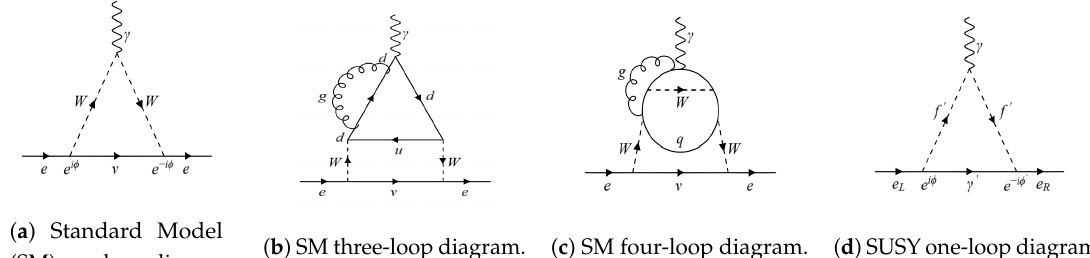
Figure 1. ( a ) One-loop Standard Model (SM) contribution to the electric dipole moment of the electron (eEDM). The phases in the two vertices cancel out, leaving behind no charge–parity (CP) violating contributions, resulting in zero eEDM at the one-loop level. ( b ) It turns out that there are no contributions at the two- and three-loop levels either; a sample three-loop diagram has been given above, and although an individual three-loop diagram itself may not vanish, the non-zero diagrams eventually cancel out [16], ( c ) The first non-zero contribution to the SM eEDM occurs at the four-loop level [17], and ( d ) supersymmetry (SUSY) contribution to the eEDM. The phases at the two vertices are different, and therefore, one can obtain a non-zero contribution to the eEDM at the one-loop level itself. This is also why the eEDMs in most beyond the SM (BSM) are much larger than their SM counterpart